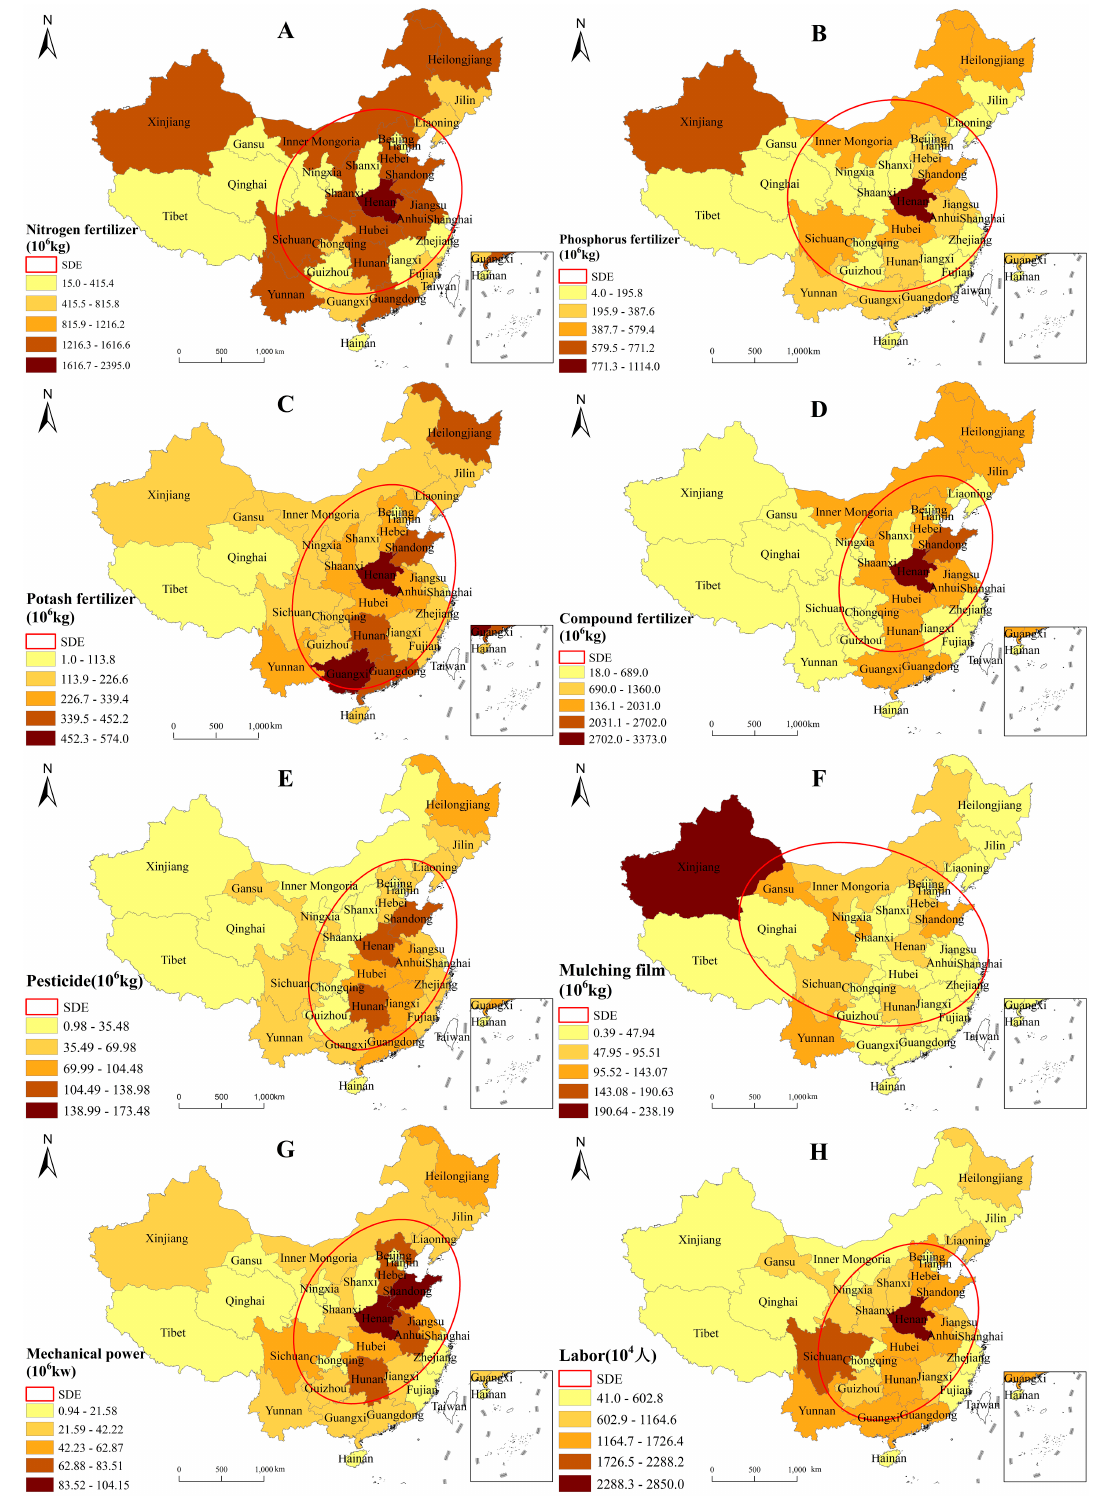
Figure 3. Input of production material on arable land in 2018. In terms of specific inputs, in contrast to the distribution of total input (Figures 2 and